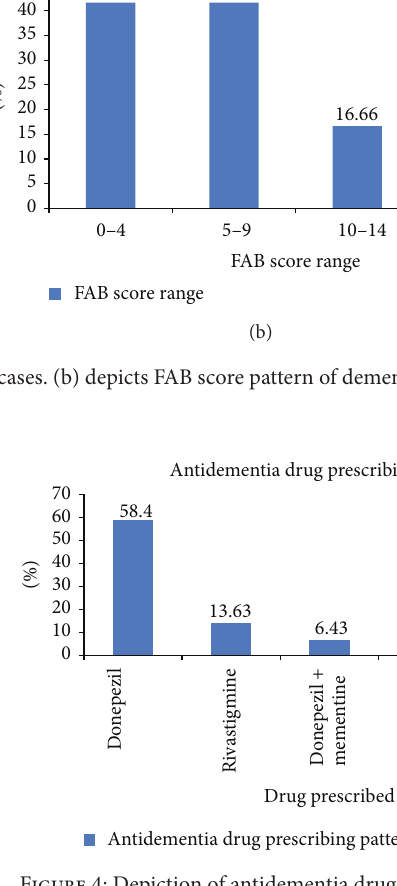
Figure 4: Depiction of antidementia drug prescribing pattern.